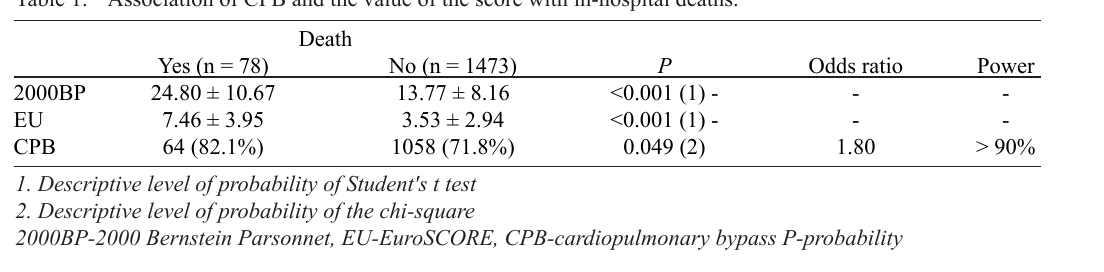
Table 2. Logistic regression model showing values Odds ratio for the presence of 2000BP and CPB.